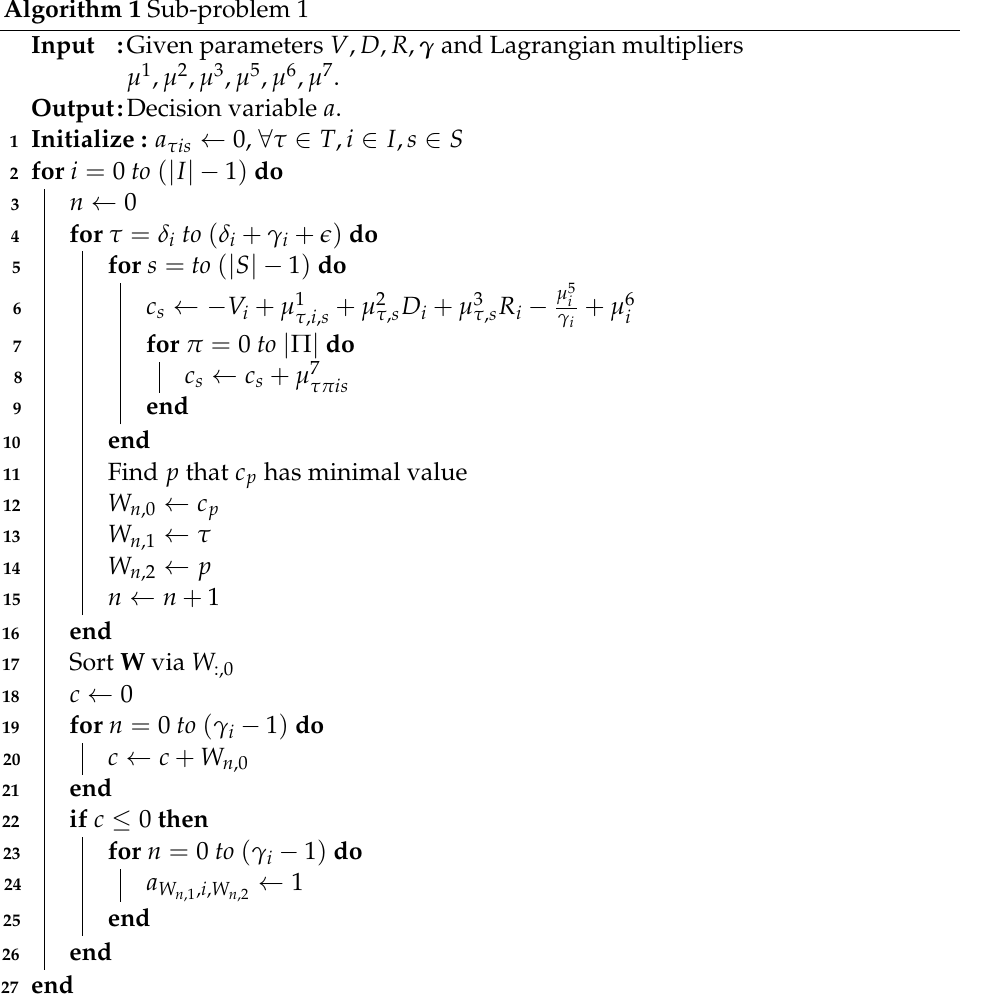
Algorithm 1 Sub-problem